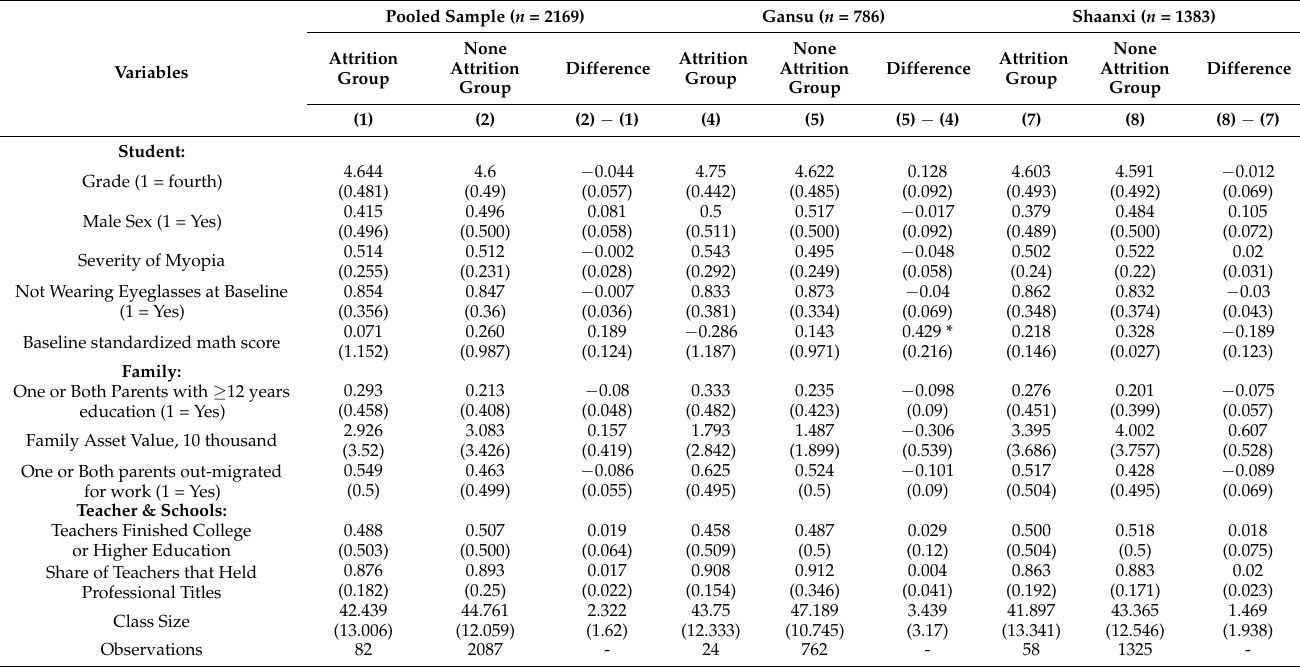
Table A1. Baseline characteristics difference between attrition and no missing